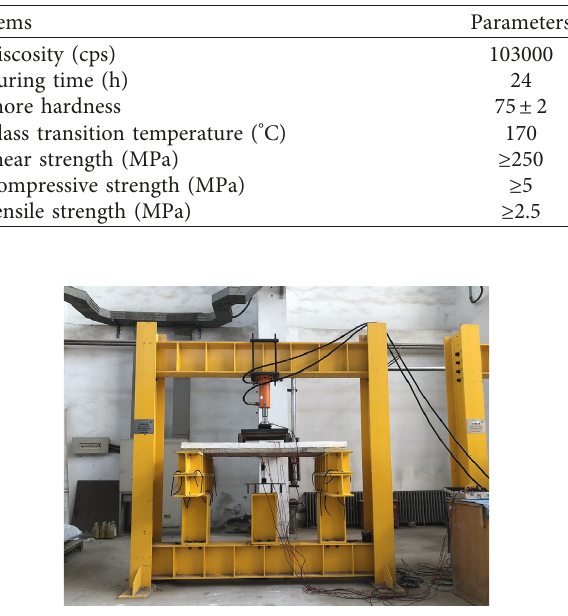
Figure 3: Experimental setup for the